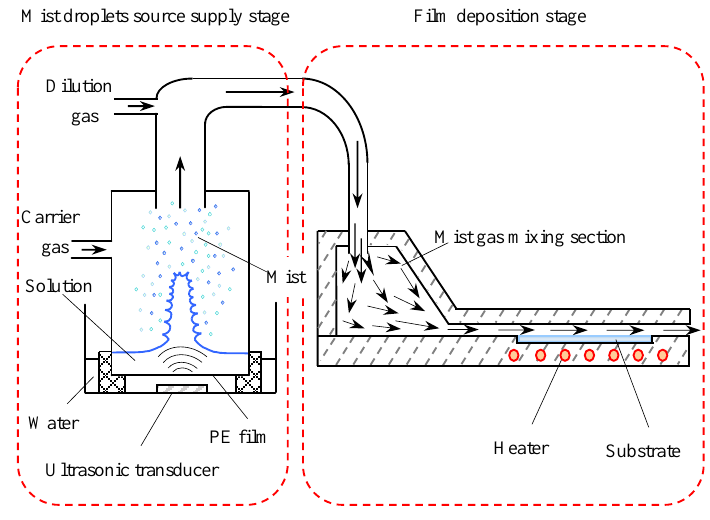
Figure 1. Schematic diagram of fine channel mist chemical vapor deposition (CVD) equipment.